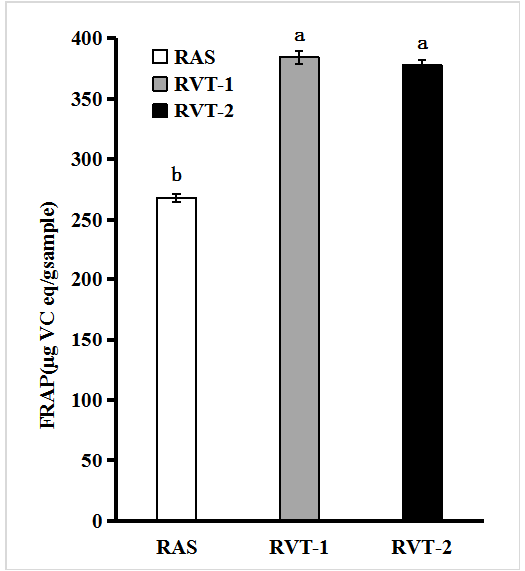
Figure 1. FRAP assays for RVT and RAS. Values with different letters within the same substance are significantly different ( p < 0.05). All data were expressed as the means ± SD, n = 3. To evaluate the scavenging ability of the samples more accurately to DPPH and O 2 − radicals, the IC 50 values of DPPH and O 2 − radicals are shown in Figure 2. The IC 50 of the (1.373 mg/mL). The IC 50 of RVT-1 and RVT-2 are similar. The difference between the two